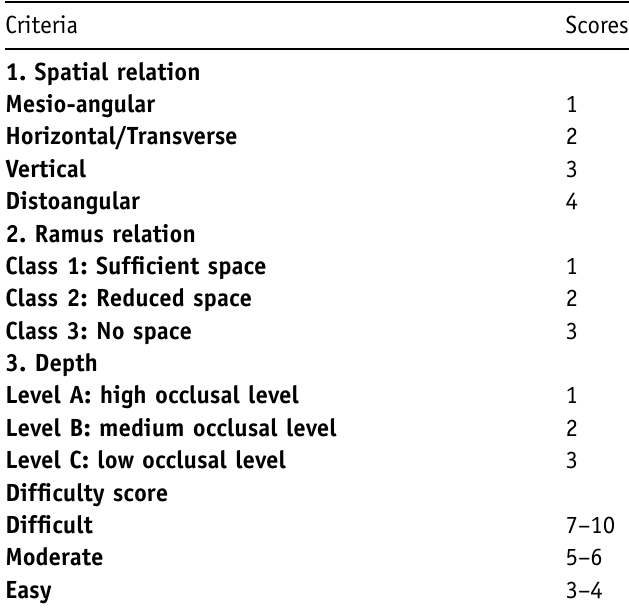
Table I. Criteria and scores of the Pederson